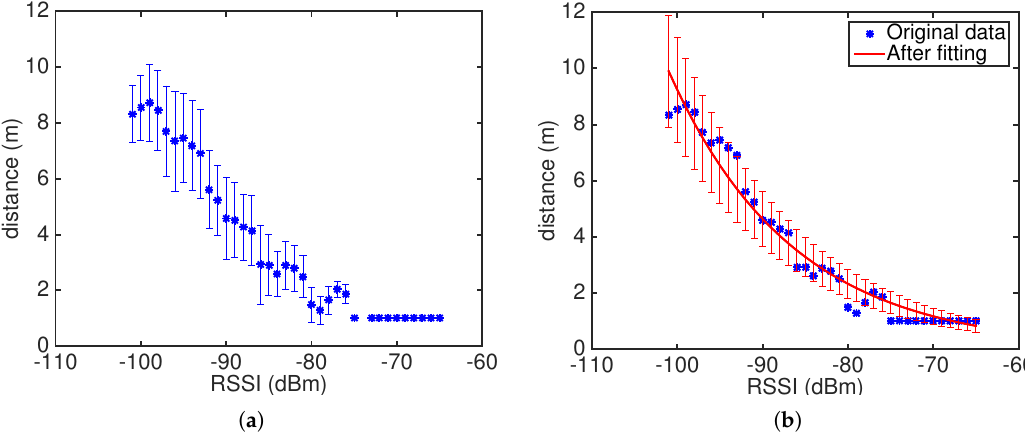
Figure 15. ( a ) RSSI vs. distance mapping plot with raw calibration data. ( b ) RSSI vs. distance mapping plot with a fitted path loss exponent n = 2.36, and the SD of distance measurement error σ ij ( d ) = 0.27 d